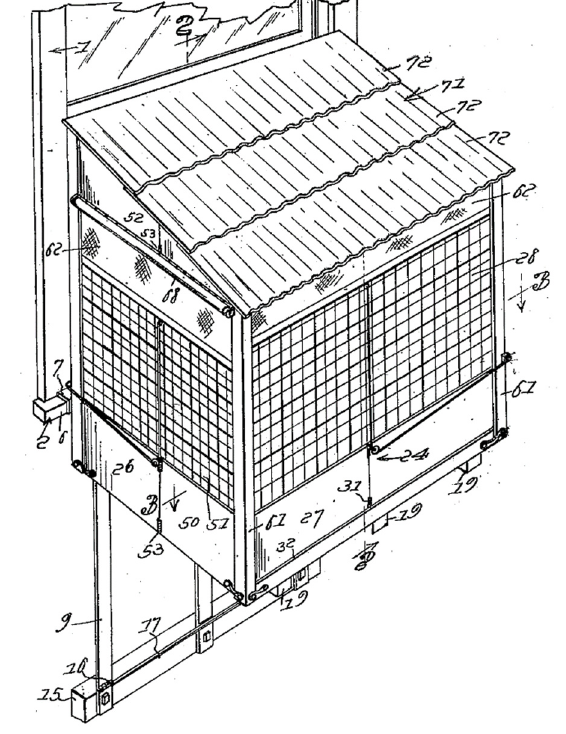
Figure 20. Details from 1922 Patent Application #1448235 for a “Baby Cage” (Read 1923).